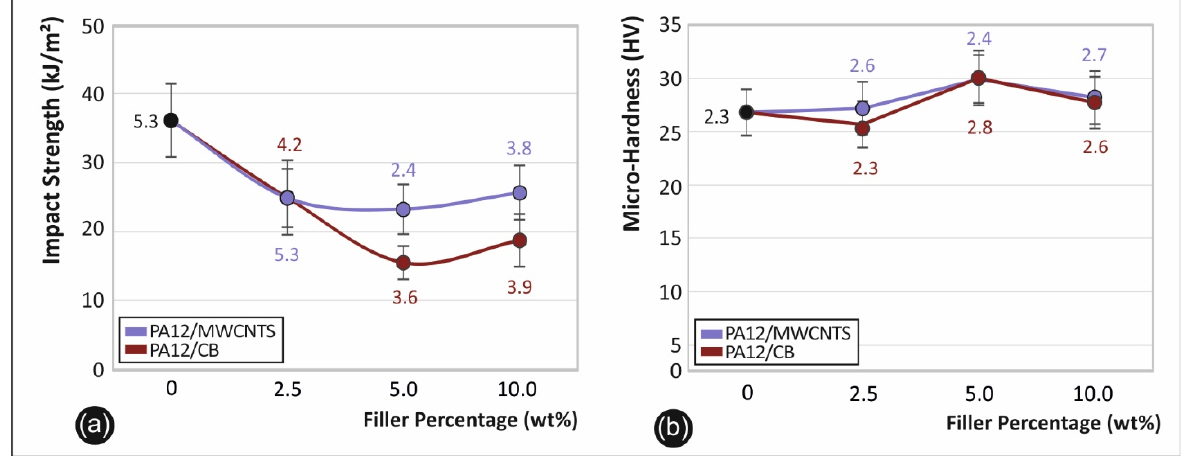
Figure 14. ( a ) Charpy’s notched impact test results (kJ/m2), and ( b ) microhardness (Vickers (HV)) performance of the PA12/CNT and PA12/CB nanocomposites (both properties are shown as the calculated mean values, together with the corresponding standard deviation).